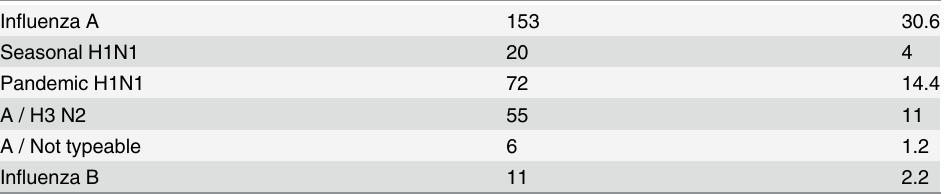
Table 2. Number (%) of Subjects positive for In fl uenza Virus